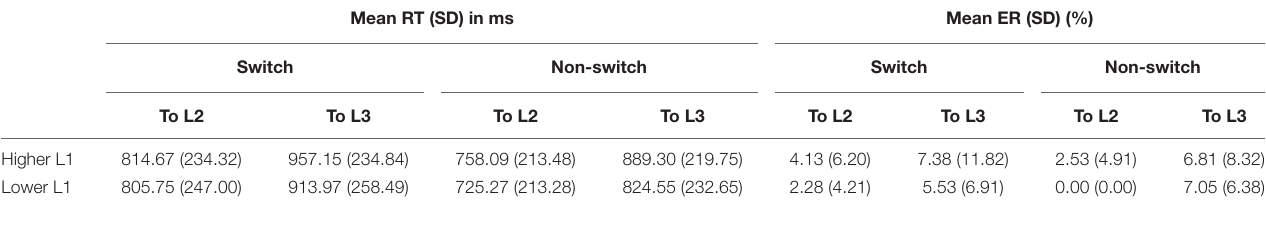
TABLE 4 | RTs and ERs in experiment